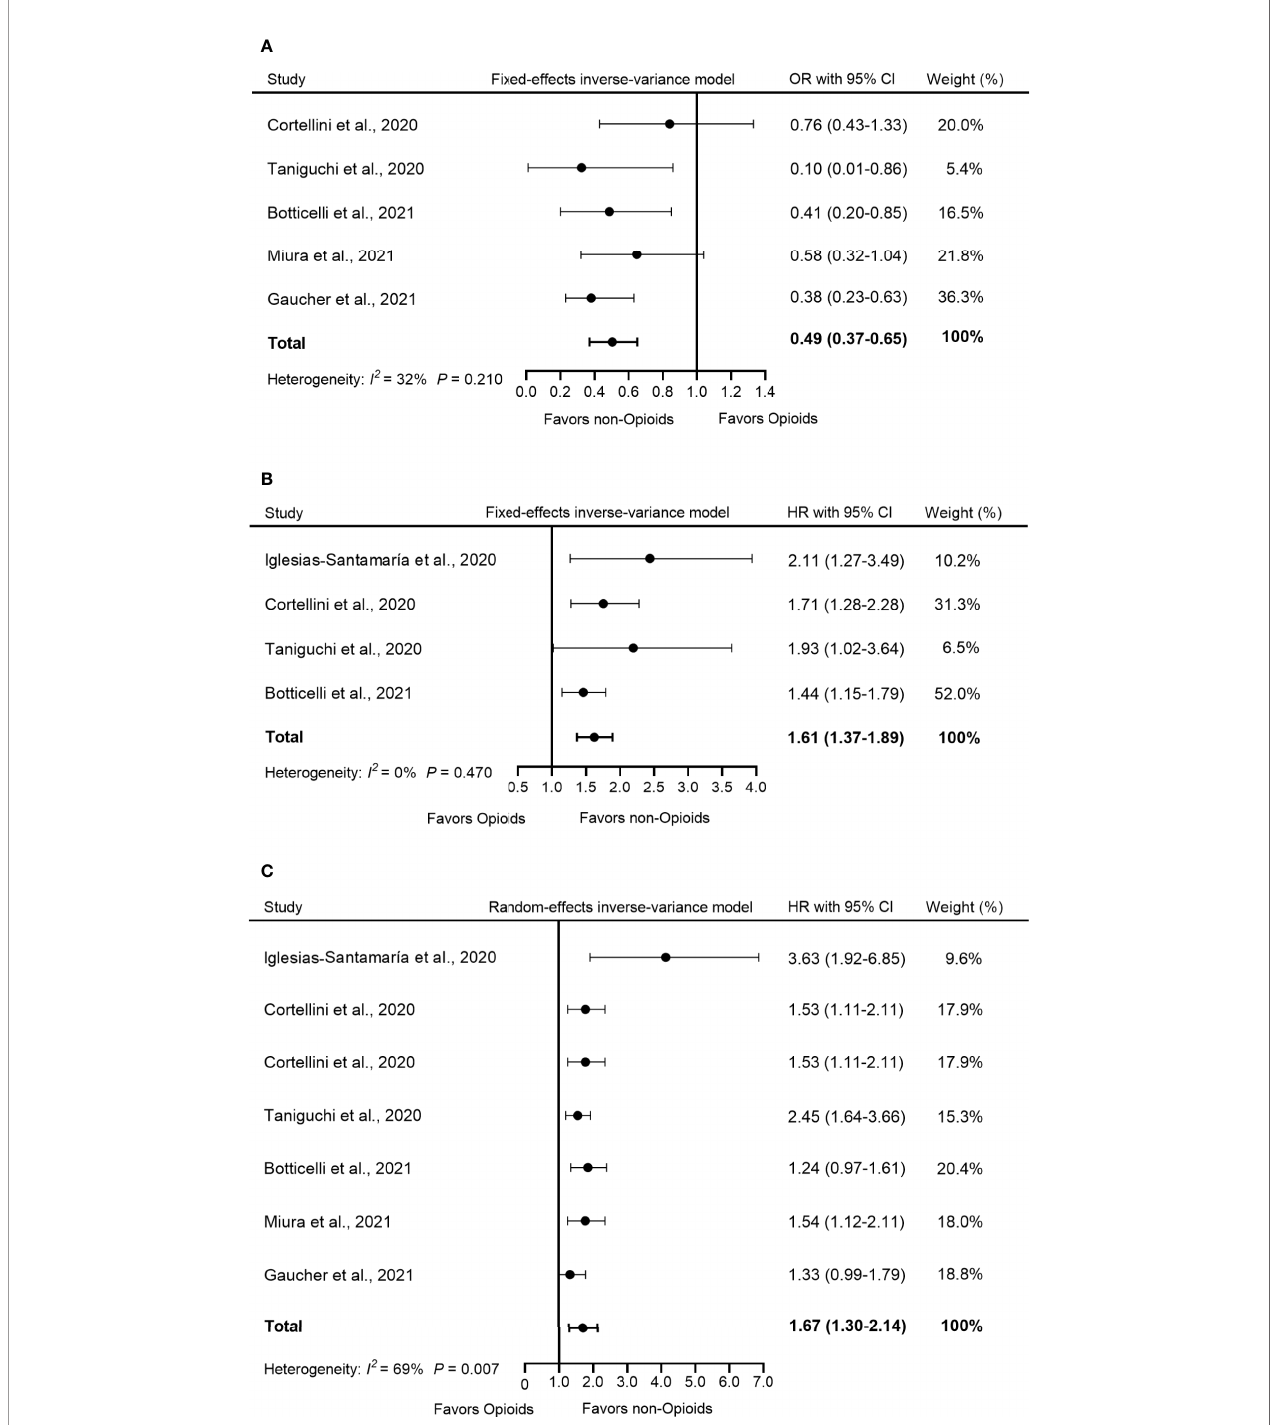
FIGURE 2 | Forest plot of the correlation between concomitant use of opioids and (A) ORR, (B) PFS, and (C) OS in patients receiving ICIs. The pooled OR of ORR was 0.49 (95% CI = 0.37 – 0.65, p < 0.001) and the fi xed-effects model was adopted. The pooled HR of PFS was 1.61 (95% CI = 1.37 – 1.89, p < 0.001) and the fi xed- effects model was adopted. The combined HR of OS was 1.67 (95% CI = 1.30 – 2.14, p < 0.001) and the random-effects model was adopted. By de fi nition, OR > 1 or HR < 1 implied a better prognosis for opioid users. ORR, objective response rate; PFS, progression-free survival; OS, overall survival; OR, odds ratio; HR, hazard ratio; CI, con fi dence interval; ICIs, immune checkpoints